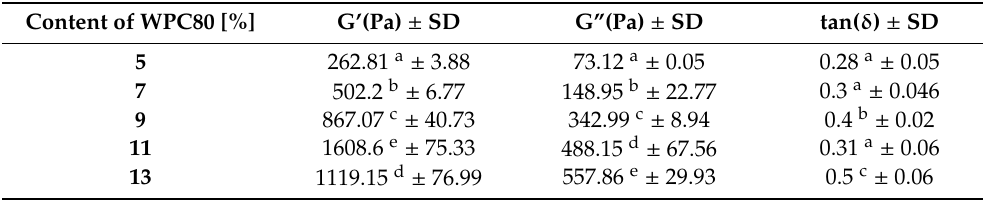
Table 3. E ff ect of di ff erent WPC80 contents on storage (G’) and loss (G”) moduli, and tan( δ ) of high-protein fat-free dairy